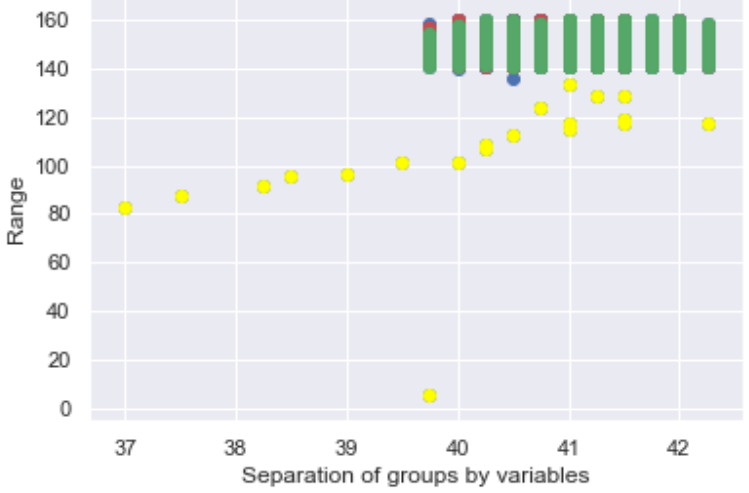
Figure 19. GMM distribution of the 2 classes on the